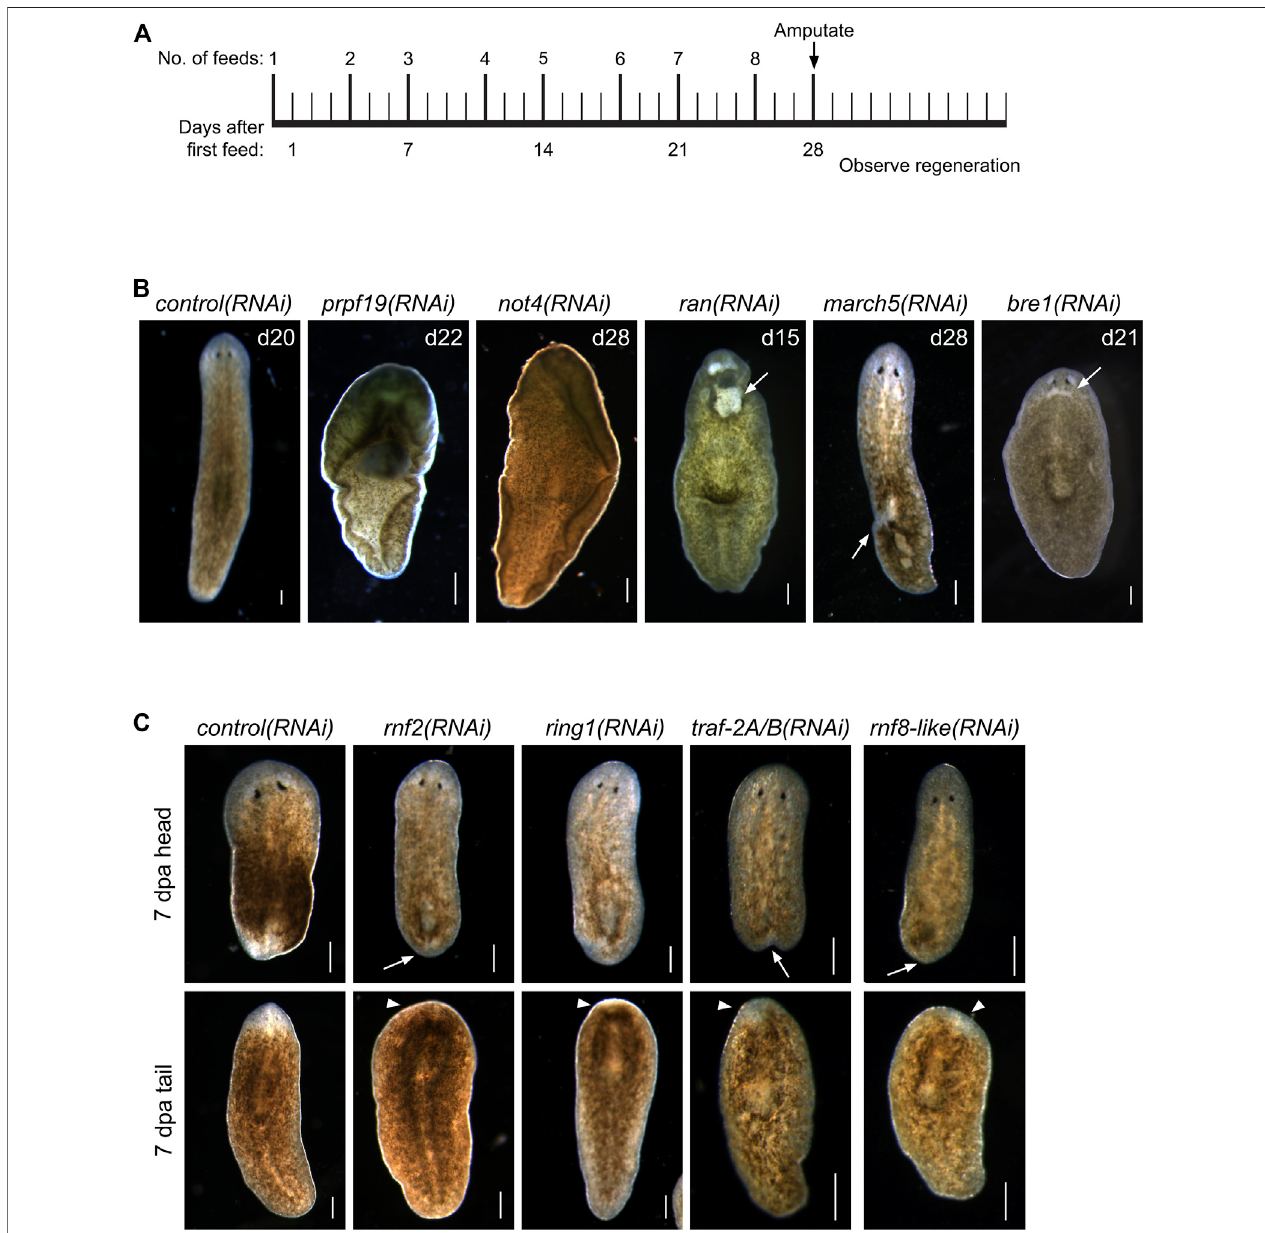
FIGURE 1 | RNAi screen of RING/U-Box E3 ubiquitin ligases identi fi es regulators of stem cells and regeneration. (A) Feeding and amputation schedule of RNAi screen. Worms were fed twice per week for a total of eight feeds and amputated pre-pharyngeally on day 28. (B) Knockdown of the indicated genes resulted in phenotypes,includingventralcurling(N (cid:1) 33/121and7/37for prpf19 and not4 ,respectively)andlesions(whitearrow,N (cid:1) 11/43,18/33,and14/53for ran , march5 ,and bre1 ,respectively).Animalsareshownafter theconclusionoftheRNAifeedingsand beforeamputation. (C) Knockdown oftheindicatedgenesthatdemonstrated phenotypes of delayed or absent regeneration after amputation, as shown by the smaller than normal or absent blastemas (white arrow) and missing or faint eyespots (white arrowhead) when compared to control(RNAi) worm at the same regeneration time point (N (cid:1) 37/58, 19/29, 31/36, and 21/30 trunk fragments for rnf2 , ring1 , traf- 2A/B , and rnf8-like , respectively). Scale bars (cid:1) 200 μ m.